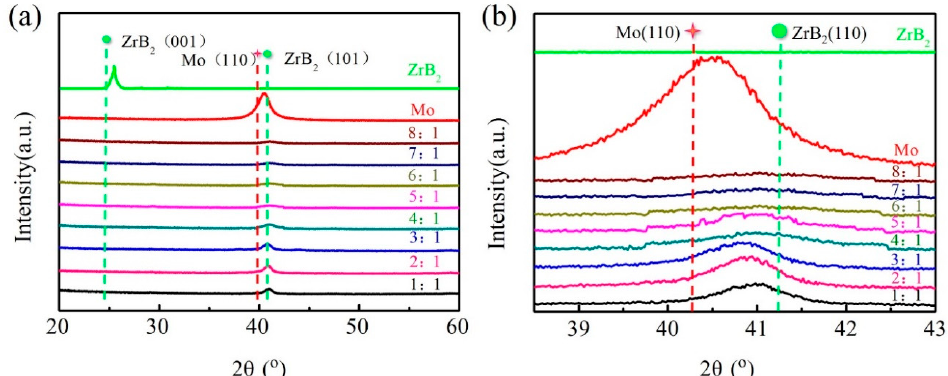
Figure 4. The XRD patterns of the ZrB 2 and Mo monolayers along with the ZrB 2 / Mo multilayers with different t ZrB2 : t Mo ( a ), and the XRD partial magnification of the image ( b ).